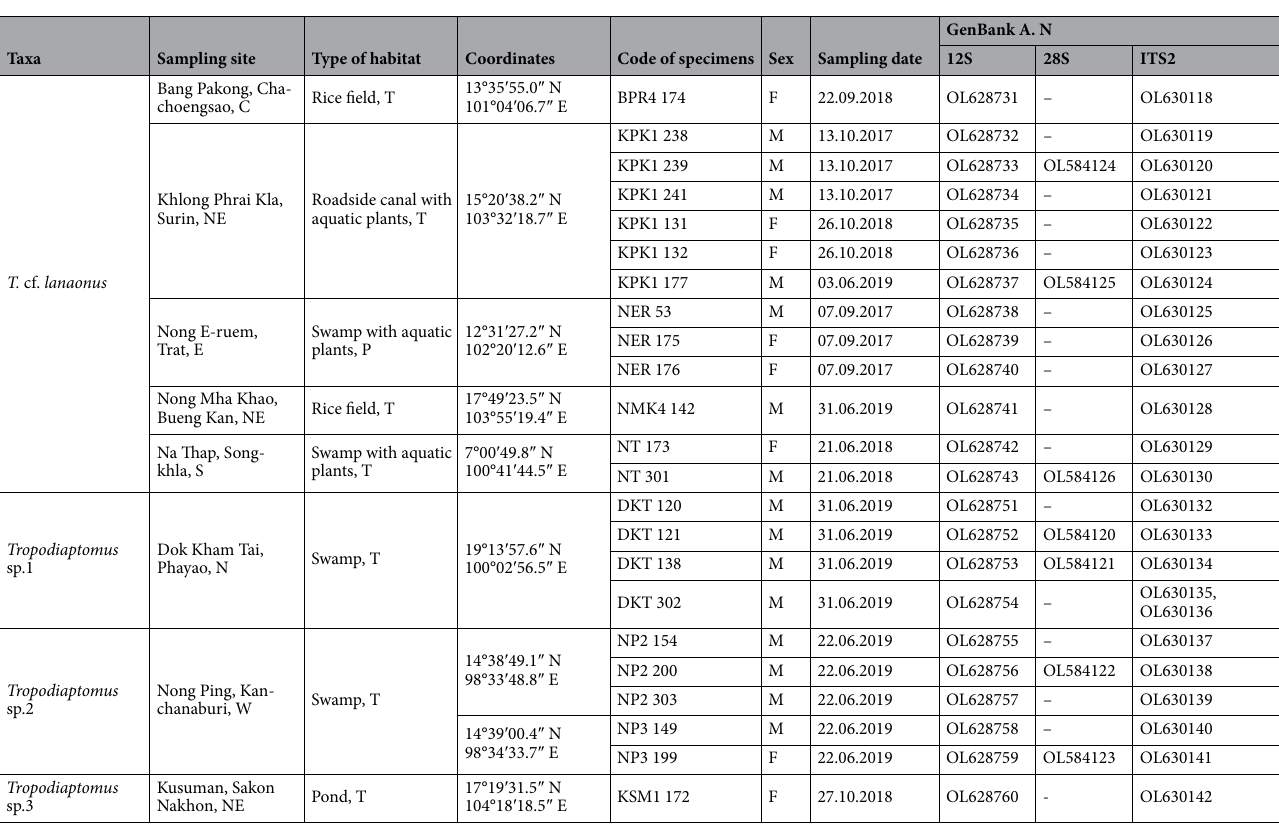
Table 1. Synopsis of the Tropodiaptomus species investigated in the frame of present study, information about the sampling locality, and GenBank Accession Numbers, A.N. Sampling site: locality name, province, geographical region; C central, E eastern, N northern, NE northeastern, S southern, W western; type of habitat: P permanent habitat type, T temporary habitat